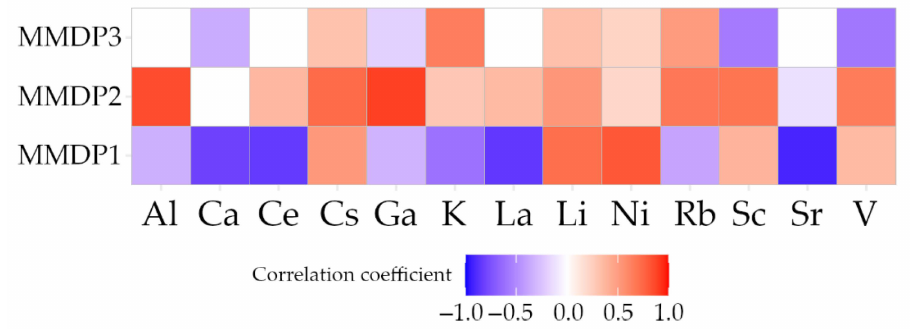
Figure 6. Correlation of the three MMDP with the 13 IMDP. Non-significant correlations are displayed in